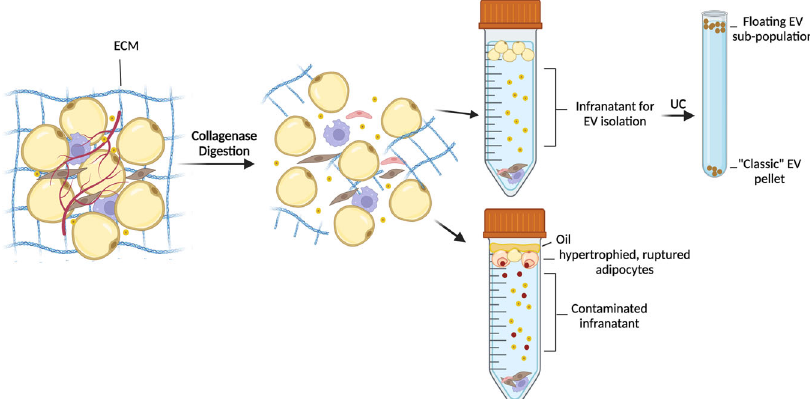
Fig. 1 Challenges of EV isolation from adipose tissue. Collagenase digestion is required to liberate cells from the extracellular matrix (ECM) and produce a single-cell suspension. Adipocytes are fragile under these conditions and may burst, particularly if they are hypertrophied. If adipocytes are ruptured, the infranatant, where tissue EVs are found, will be contaminated with intracellular vesicles. Once a clean infranatant is collected, EVs can be isolated through various techniques, however if ultracentrifugation (UC) is used a population of triglyceride-containing EVs may not pellet and, instead, fl oat. Images were created with